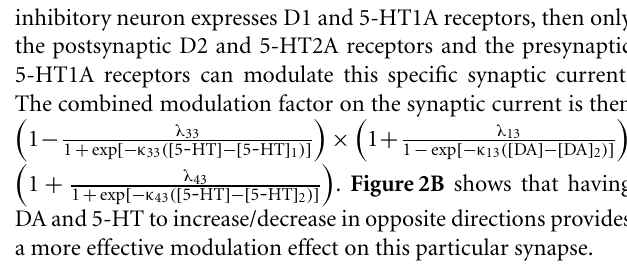
Table 5 | Modulation factors of DA and 5-HT on synaptic currents. AMPA NMDA GABA